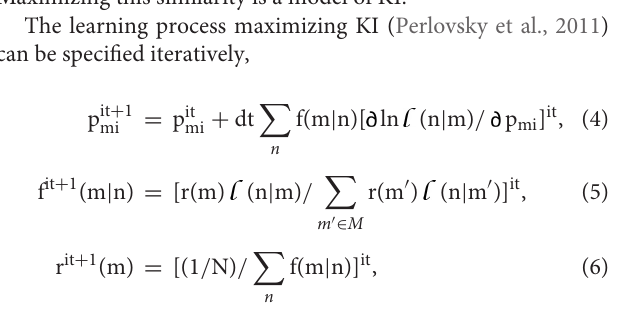
Frontiers in Systems Neuroscience |